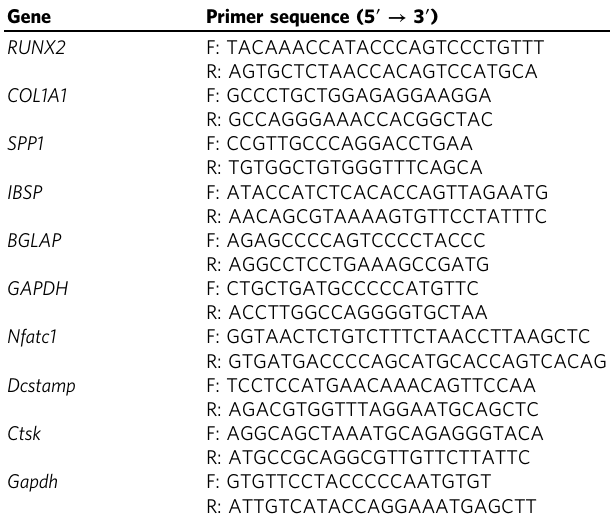
Table 1 Primers sequences used for